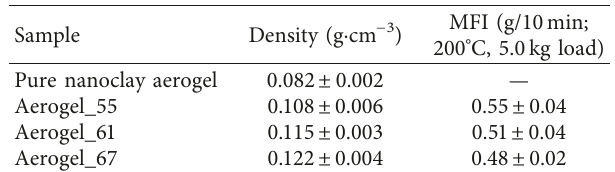
Figure 4: SEM images of nanoclay aerogel masterbatches: (a) pure nanoclay aerogel; (b) Aerogel_55; (c) Aerogel_61; (d) Aerogel_67. Table 3: Density and MFI results of nanoclay aerogel